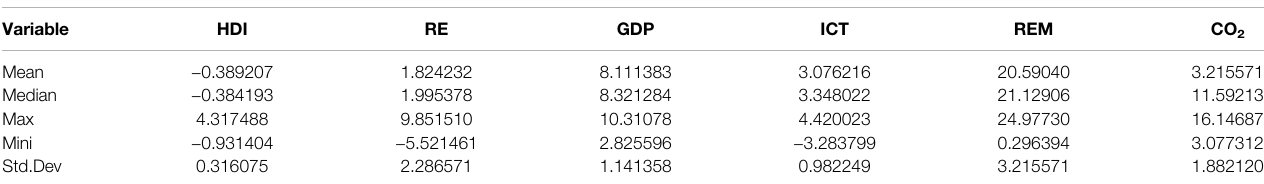
TABLE 2 | Descriptive Statistics of the